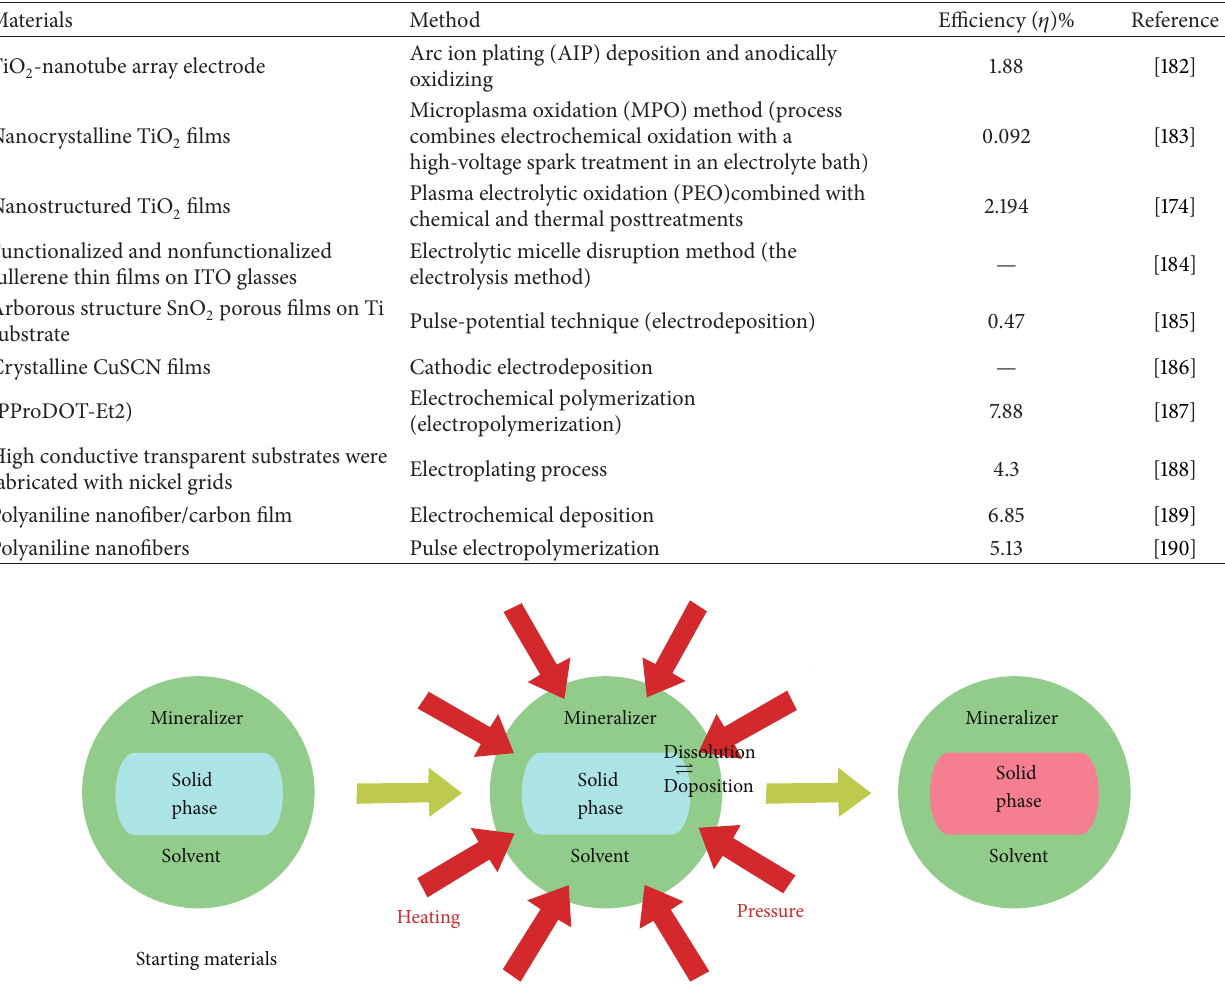
Figure 7: Schematic of the hydrothermal synthesis procedure